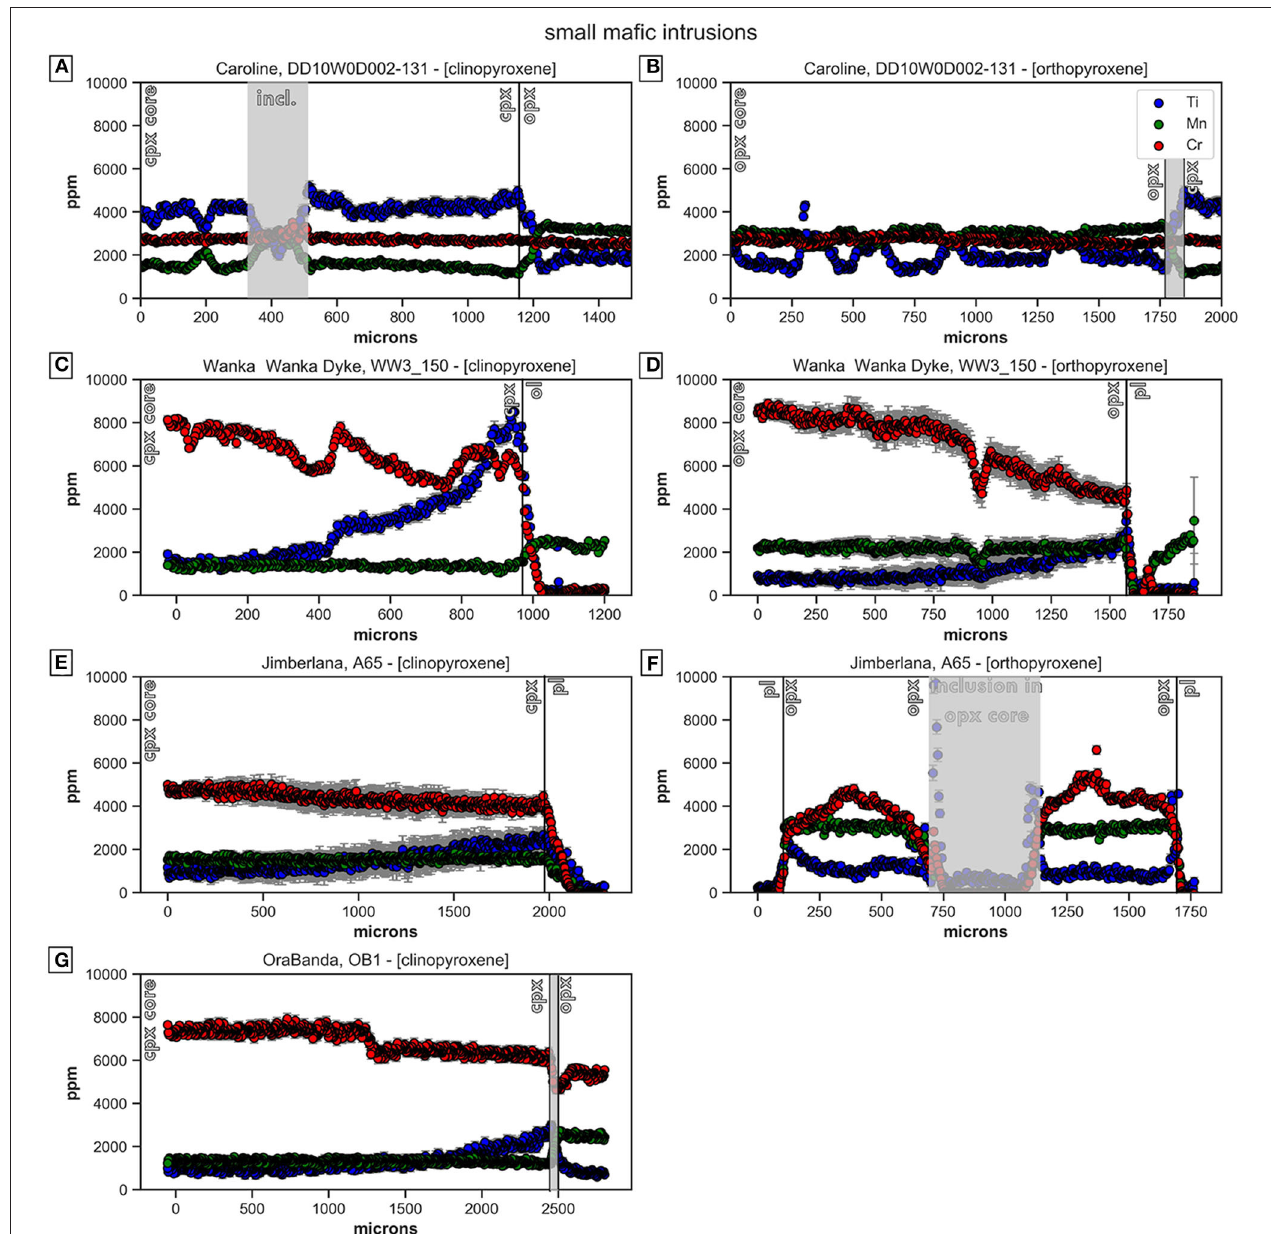
FIGURE 10 | Traverses across clinopyroxene and orthopyroxene from core to rim in mafic intrusions. (A,B) A clinopyroxene and orthopyroxene traverses from the Ngunala (Caroline) intrusion, (C,D) clinopyroxene and orthopyroxene traverses from the Wanka Wanka Dyke ( Figure 9A ), (E,F) clinopyroxene and orthopyroxene traverse from the Jimberlana intrusion ( Figure 9D ), and (G) a traverse through the large clinopyroxene oikocryst of the Ora Banda intrusion ( Figure 9E ).